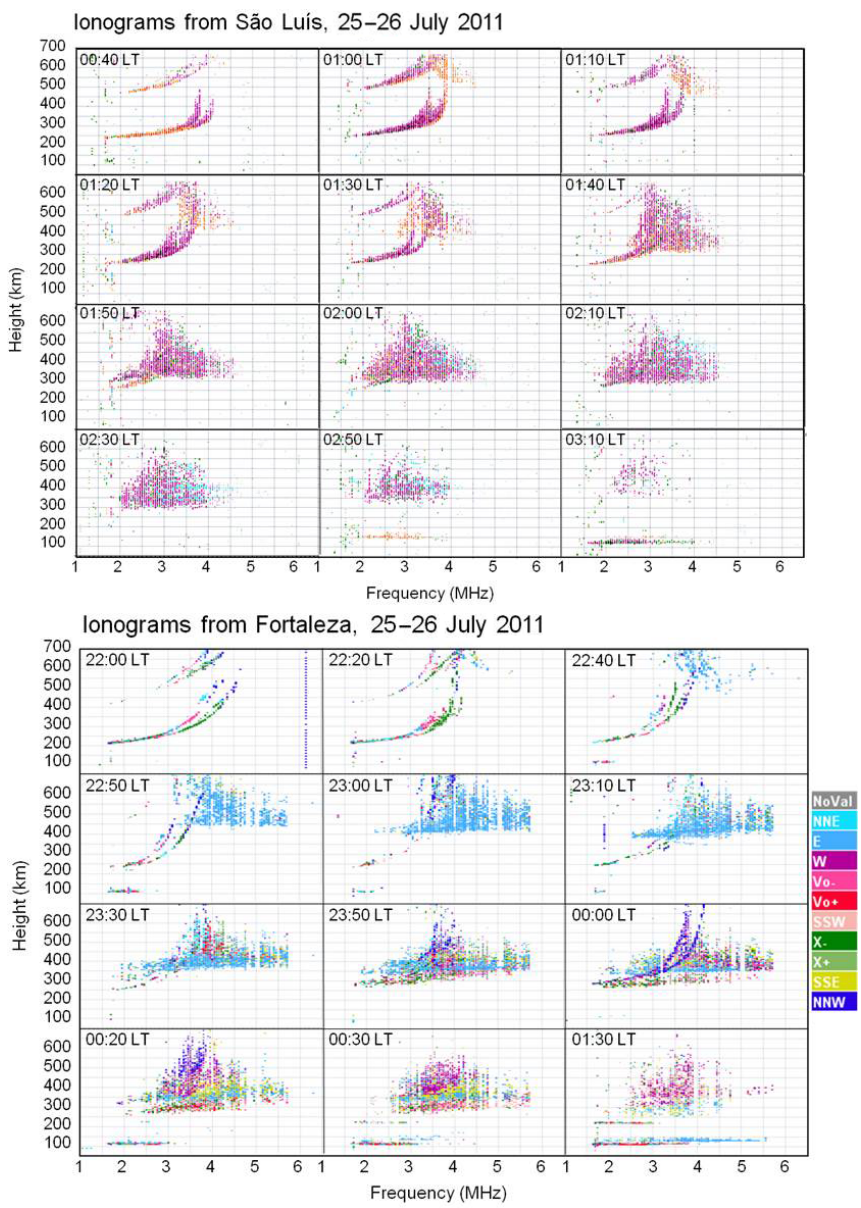
Figure 1. Sequence of ionograms obtained on 25–26 July 2011 at São Luís (SL) from 00:40 to 03:10LT and over Fortaleza (FZ), Brazil, from 22:00 to 01:30LT. The spread F shows an unusual pattern, with oblique echoes. The color scale in FZ ionograms indicates that echoes are coming from the east and propagating